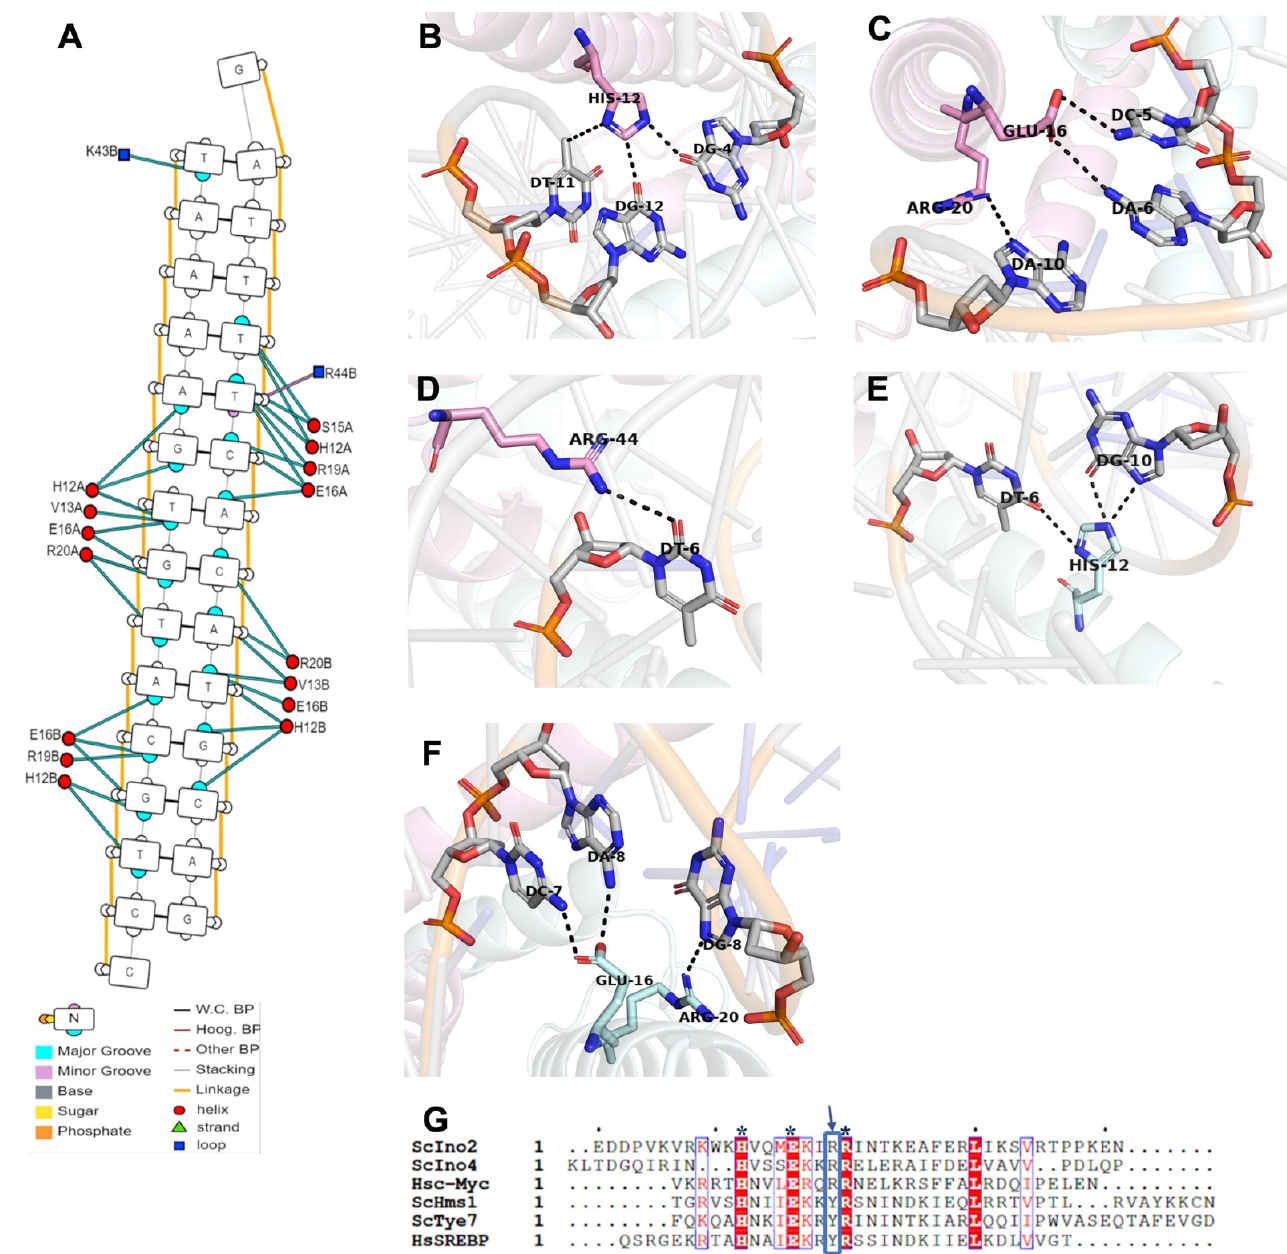
Figure 3. DNA recognition and binding pattern of Ino2p DBD and Ino4p DBD : ( A ) Schematic presenta- tion of the interaction between protein and DNA; ( B – D ) Interaction of Ino2p DBD and; ( E , F ) Ino4p DBD with the nucleotides in the promoter DNA fragment; ( G ) Multiple-sequence alignment of different bHLH proteins. Sc denotes Saccharomyces cerevisiae, and Hs denotes Homo sapiens. * indicates the conserved residues in the bHLH proteins, while the blue arrow points to the replacement of conserved residue “R” with “Y”.